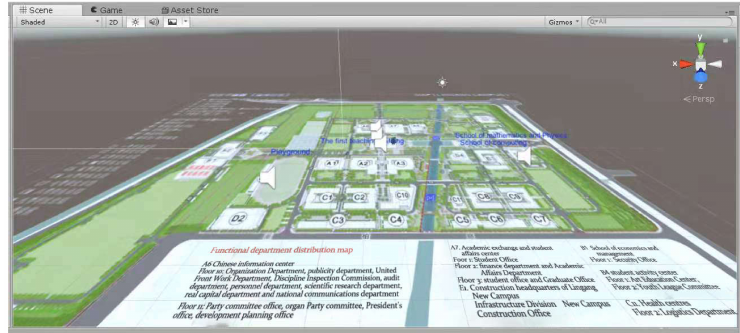
Figure 7. Campus plan of Shanghai University of Electric